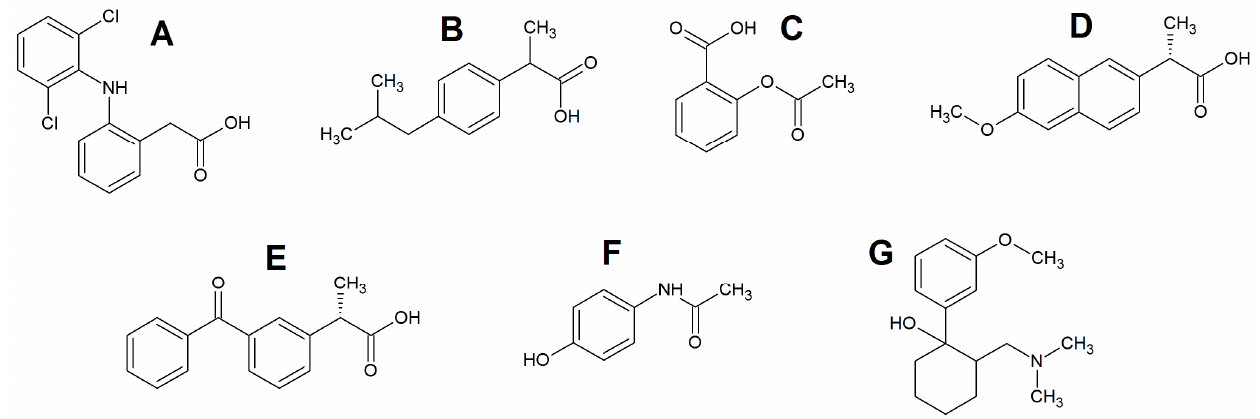
Figure 2. The structural formulas of diclofenac ( A ), ibuprofen ( B ), acetylsalicylic acid ( C ), naproxen ( D ), ketoprofen ( E ), paracetamol ( F ) and tramadol ( G